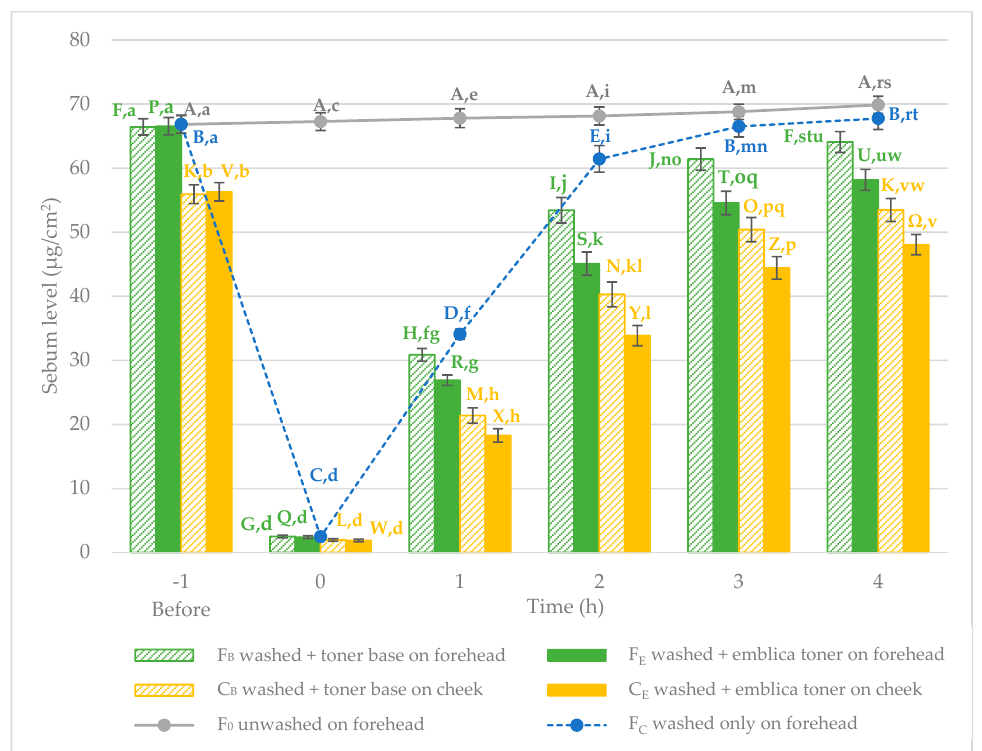
Different capital letters ( A–Z, Ω ) in the same column indicate statistically significant differences ( p < 0.05) when compared within the same column. Different lower case letters ( a–w ) in the same row indicate statistically significant differences ( p < 0.05) when compared within the same row.